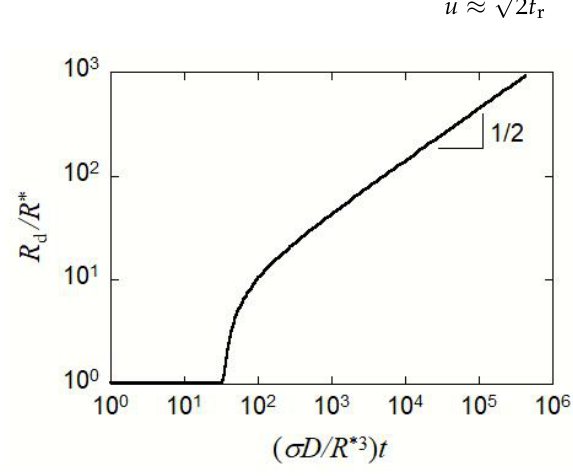
Figure 5. Time dependence of the growing droplet radius ( R d = R * at t = 0) in the micellar solution, calculated by Equation (25).